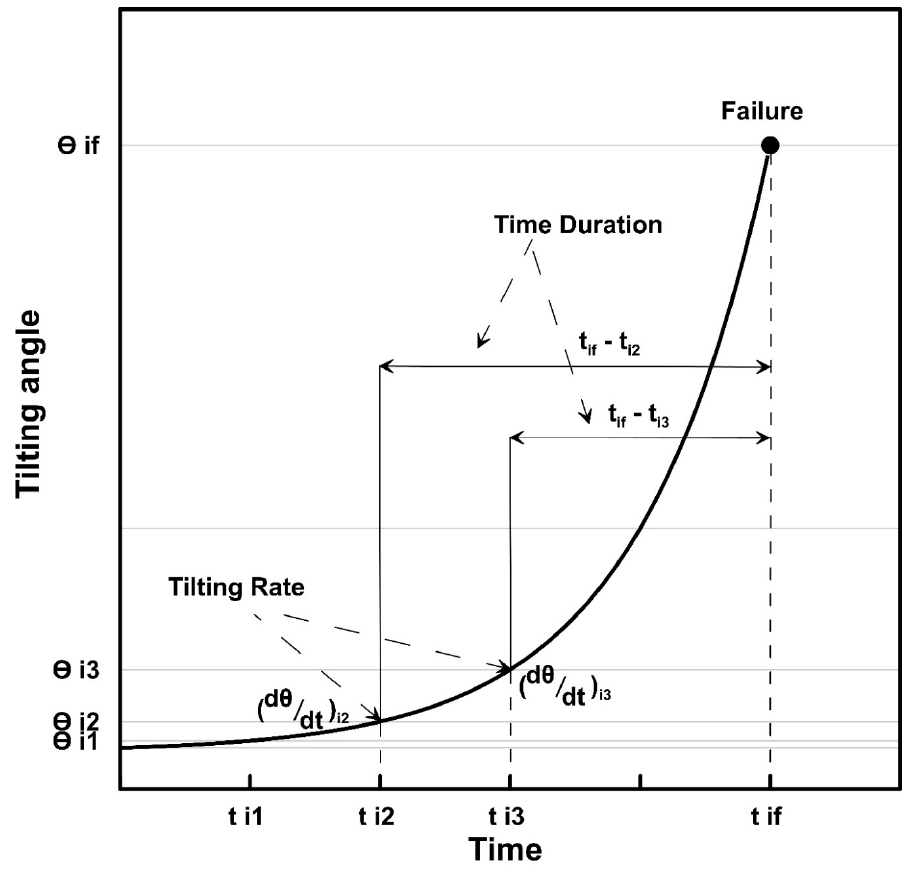
Figure 5. Definition of tilting rate and time duration (modified after Xie et al. ( 2019) [23]).